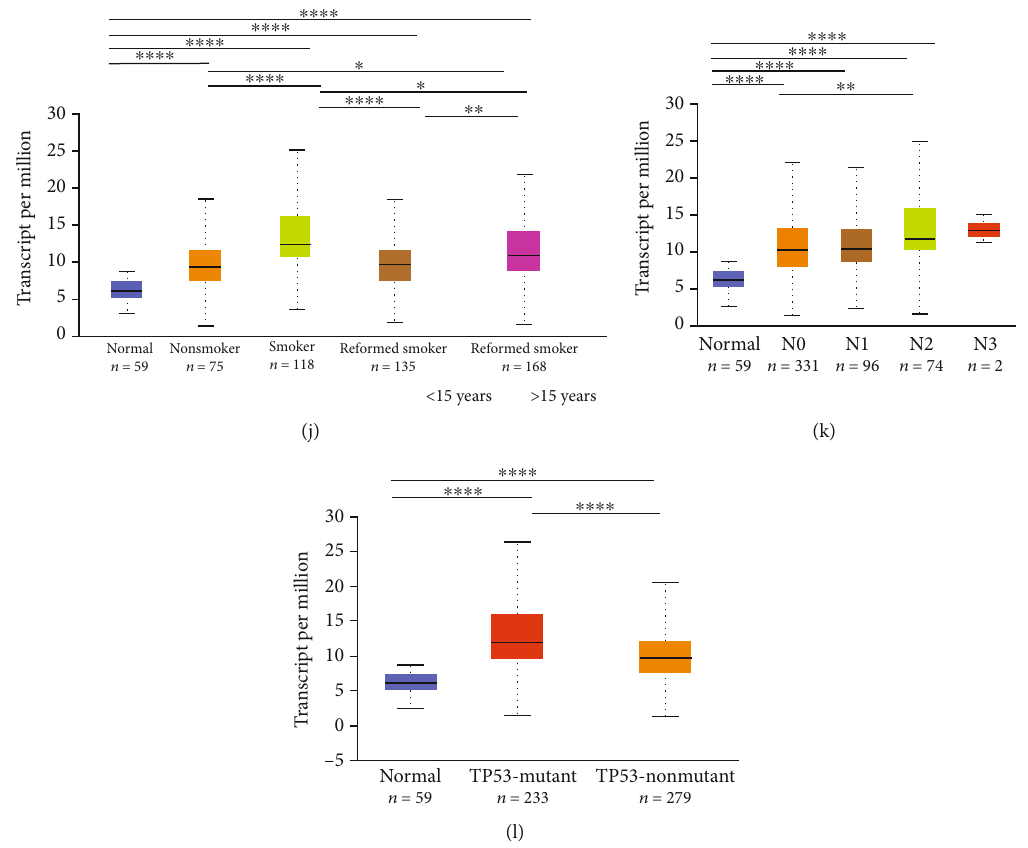
Figure 3: DHX37 transcription in subgroups of patients with hepatocellular carcinoma and lung adenocarcinoma, strati fi ed based on gender, disease stages, pathological grade, tumor status, and TP53 mutation (UALCAN). (a, g) Boxplot showing relative expression of DHX37 in normal and LIHC or LUAD samples. (b, h) Boxplot showing relative expression of DHX37 in normal individuals and LIHC or LUAD patients in stages 1, 2, 3, or 4. (c, i) Boxplot showing relative expression of DHX37 in normal individuals of either gender and male or female LIHC and LUAD patients. (e, k) Boxplot showing relative expression of DHX37 in normal individuals and LIHC or LUAD patients with lymph node metastasis. (f, l) Boxplot showing relative expression of DHX37 in normal individuals and LIHC or LUAD patients with mutant TP53 or nonmutant TP53. (d) Boxplot showing relative expression of DHX37 in normal individuals or LIHC patients with grade 1, 2, 3, or 4 tumors. (j) Boxplot showing relative expression of DHX37 in normal individuals or LUAD patients with or without smoking habits. ∗ P < 0 : 05 , ∗∗ P < 0 : 01 , ∗∗∗ P < 0 : 001 , and ∗∗∗∗ P < 0 : 0001